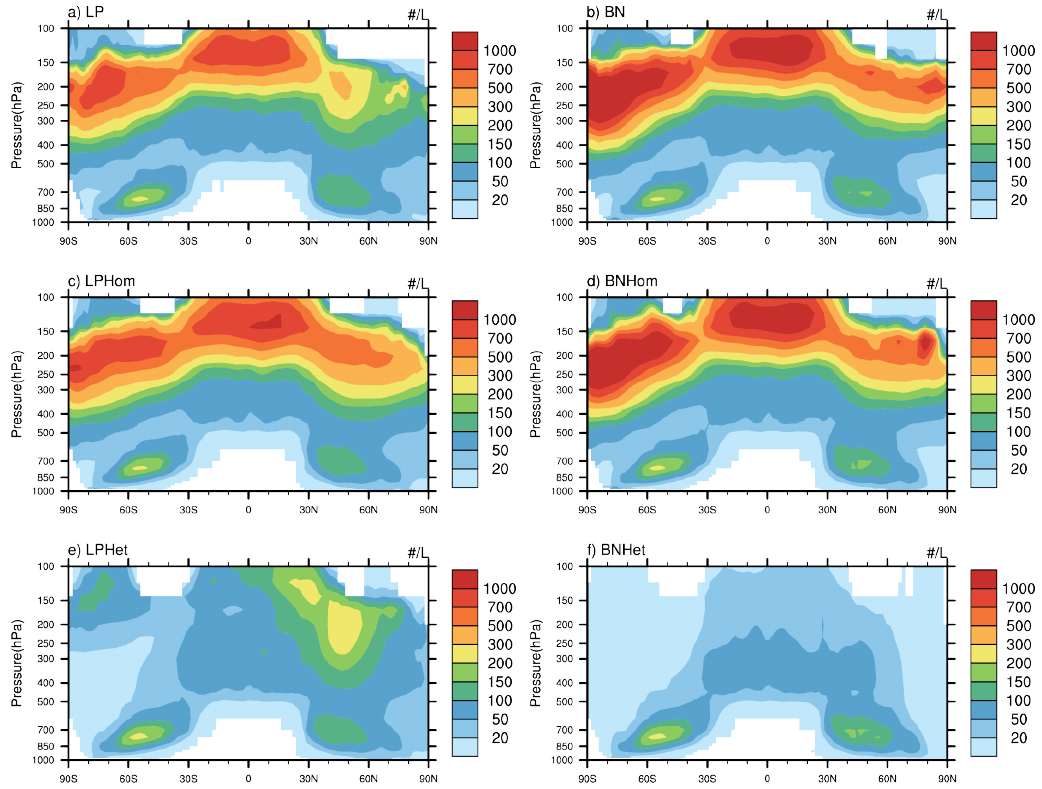
Fig. 2. Comparison of in-cloud ice crystal number concentration (L − 1 ) with LP05 (left) and BN09 (right) parameterizations for the combined homogeneous and heterogeneous nucleation (upper), pure homogeneous nucleation (middle), and pure heterogeneous nucleation (lower) simulations in CAM5.